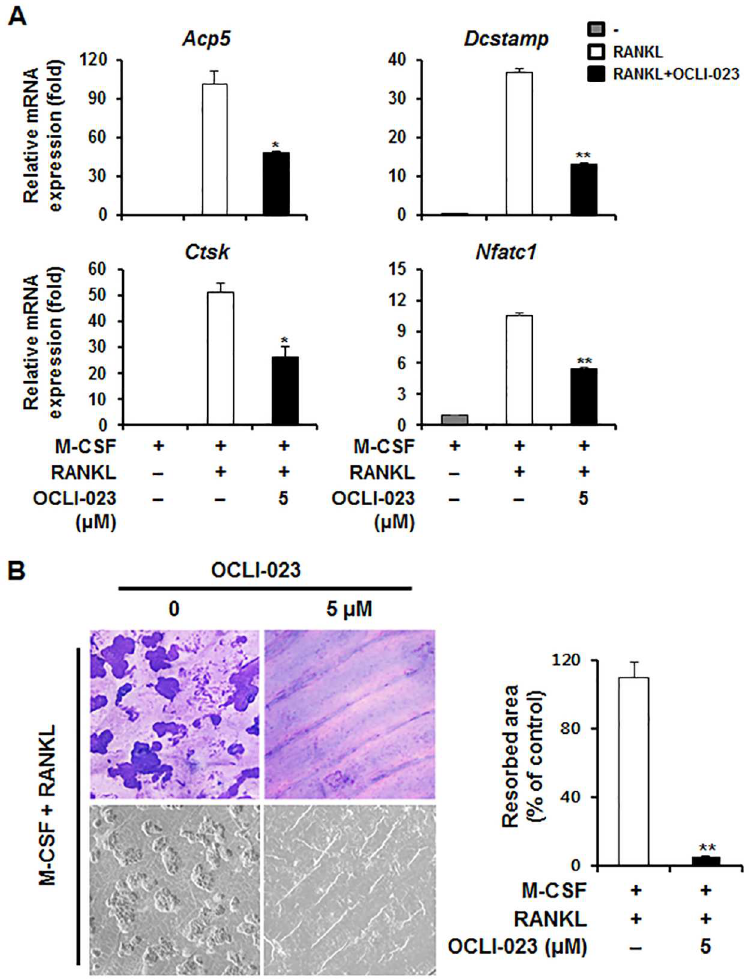
Fig 2. Effects of OCLI-023 on RANKL-induced mRNA expression during osteoclast differentiation and resorption pit formation. (A) BMMs were cultured in the presence of M-CSF (10 ng/mL) and RANKL (20 ng/ mL) with vehicleor OCLI-023 (5 μ M). The mRNA expression of TRAP ( Acp5 ), cathepsin K ( Ctsk ), DC-STAMP ( Dcstamp ), and NFATc1 ( Nfatc1 ) was analyzedusing real-time quantitative PCR. (B) BMMs were seededon bone slices and incubatedwith M-CSF (10 ng/mL) and RANKL (20 ng/mL) to induce osteoclast differentiation. After 3 days, the cells were incubatedwith or without OCLI-023 (5 μ M) for an additional 2 days. Resorption pits were observedby hematoxylin staining (upper)and scanningelectron microscopy (lower). ** p < 0.01 versus the vehicle-treated